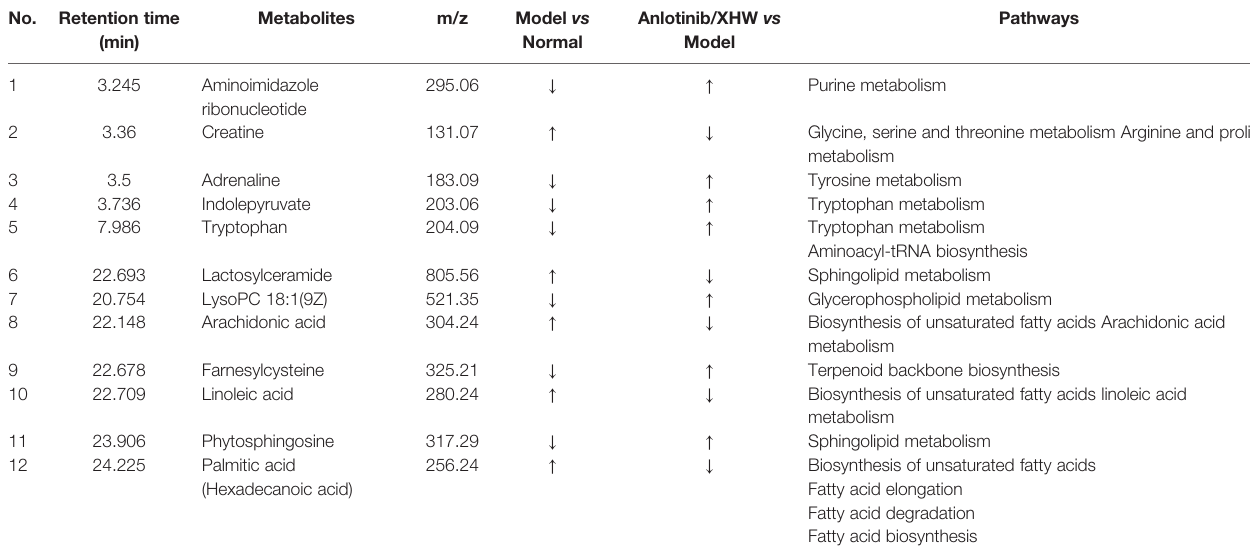
TABLE 1 | Differential metabolites and the corresponding